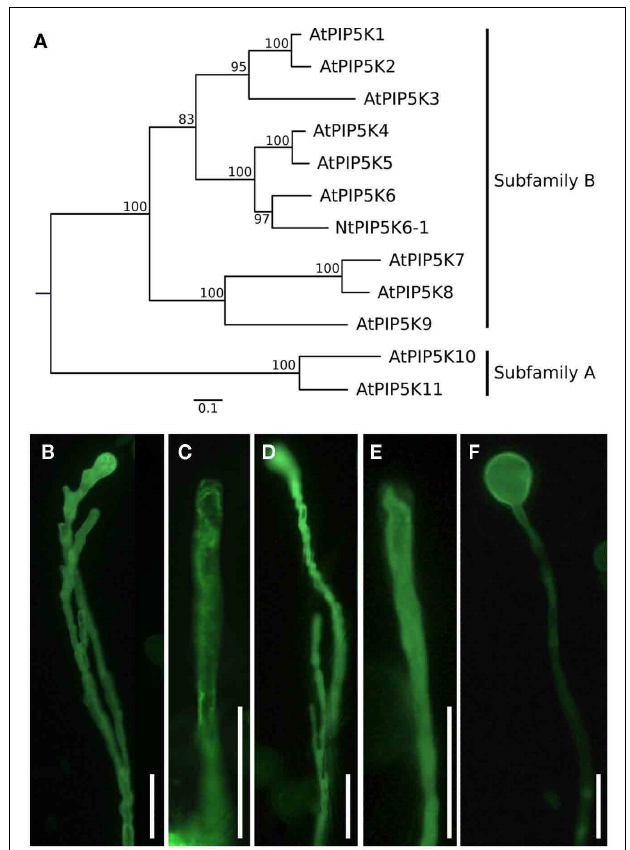
FIGURE 1 | Phylogenetic tree of plant PI4P 5-kinases and effects of PI4P 5-kinase overexpression on the morphology of tobacco pollen tubes. (A) Maximum likelihood (ML) tree created with the full-length protein sequences of A. thaliana PI4P 5-kinases and N. tabacum PIP6K6-1.Values on nodes represent% ML bootstrap support. Association of isoforms with PI4P 5-kinase subfamilies A and B according to Mueller-Roeber and Pical (2002), as indicated. (B–F) Selected PI4P 5-kinases of subfamily B were overexpressed in tobacco pollen tubes and the effects on growth were monitored. (B,C) Pollen tube branching (B) and protoplast trapping (C) upon expression of AtPIP5K5; (D, E) Pollen tube branching (D) and protoplast trapping (E) upon expression of NtPIP5K6-1; (F) Tip swelling upon expression of AtPIP5K2. Images are representative for ≥ 300 transgenic pollen tubes observed. Bars, 50 μ